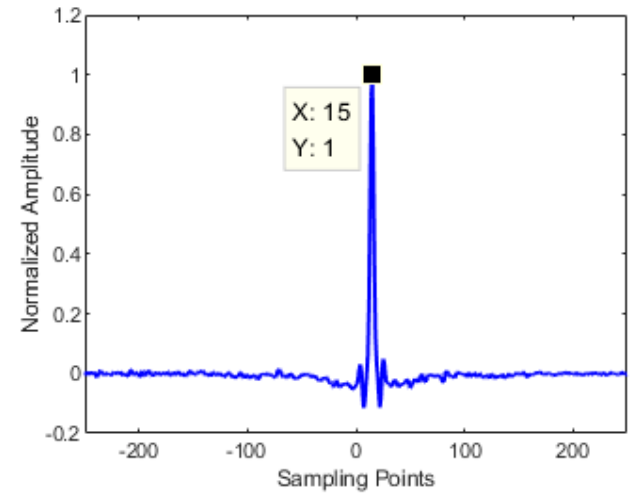
Figure 5. Time delay estimation by cross-correlation method.